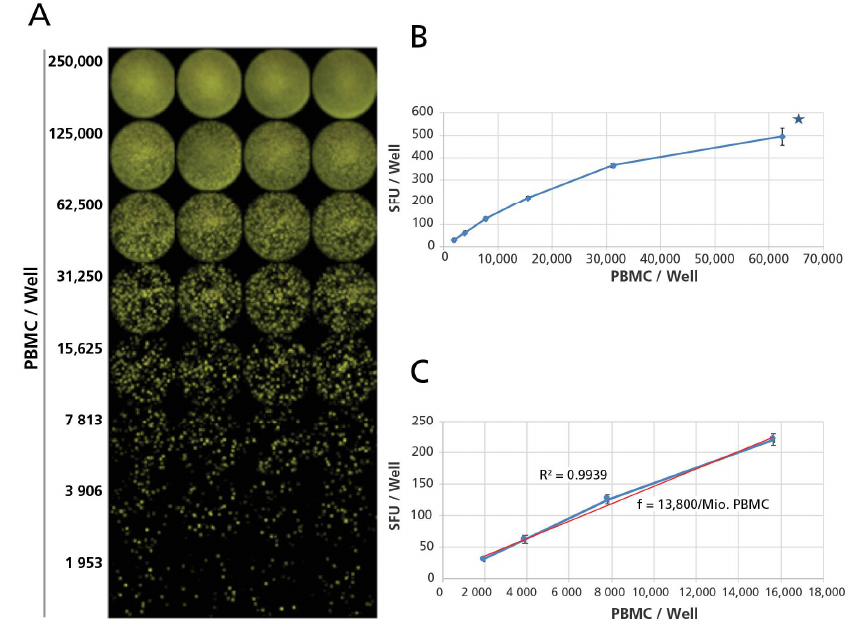
Figure 4. Calculating frequencies for pan IgG-SFU/million PBMC illustrated. Polyclonally stimulated PBMC were plated in the specified cell numbers in quadruplicate wells, and a Three Color ImmunoSpot ® assay was performed for Ig classes pan-IgG, M and A. ( A ) Raw images for the IgG color plane are shown with the cell numbers plated per well specified; ( B ) the mean spot count for each cell concentration, with the SD for the quadruplicate wells tested is plotted vs. the cell numbers plated. As the spots at high ASC densities start crowding (plus when the number of ASC is high, there is an “ELISA” effect with analyte captured from the supernatant causing a high background carpet staining), for high cell numbers Spot Forming Units (SFU) become no longer precisely countable: “too numerous to count is shown by a star; ( C ) While at high numbers spot counts tend to deviate from linearity due to crowding, in lower numbers they followed a liner relationship between cell numbers plated and SFU counted, in this case with an R 2 value of 0.9939. Based on the regression line shown in red, the pan-IgG SFU frequency has been calculated to be, in the example shown here, 13,800 pan-IgG SFU per one million PBMC.